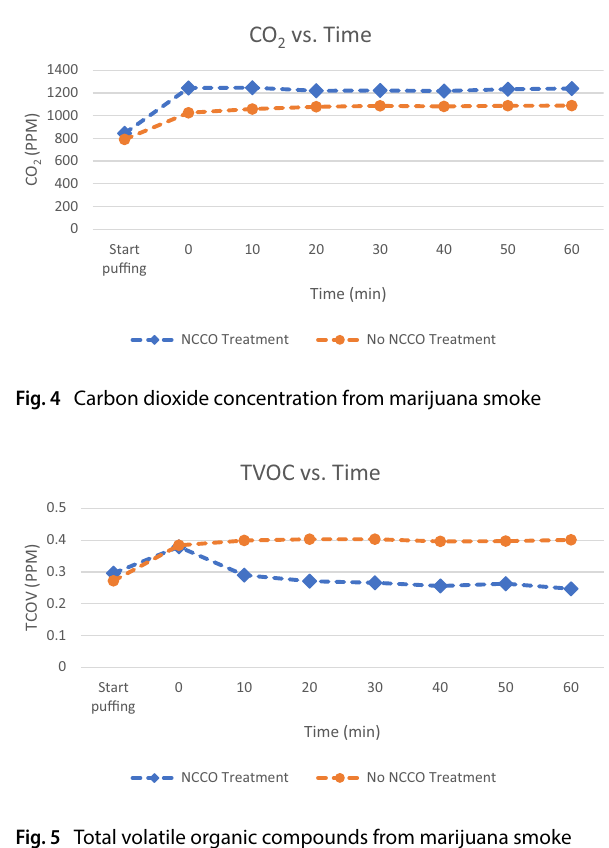
Fig. 5 Total volatile organic compounds from marijuana smoke